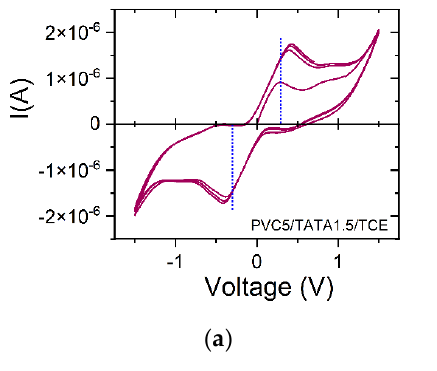
Figure 8. ( a ) Typical voltamogramms obtained at a scanning rate of 100 mV/s, I vs. V, for TATA/solvent and PVC/TATA/solvent samples. The ohmic domain is shown by blue dotted lines. ( b ) Visual presentation of a freshly prepared gel ( left ) and the gel after oxidation ( right ).